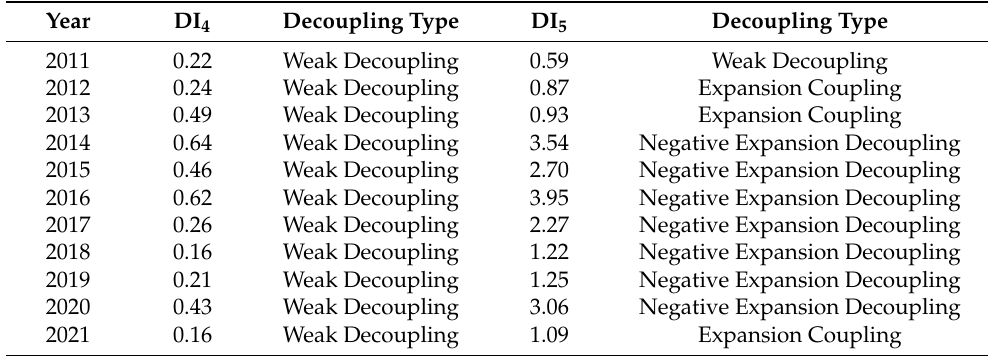
Table 7. Resource decoupling indicators of the mining industry of the Russian Federation for 2010– 2021.